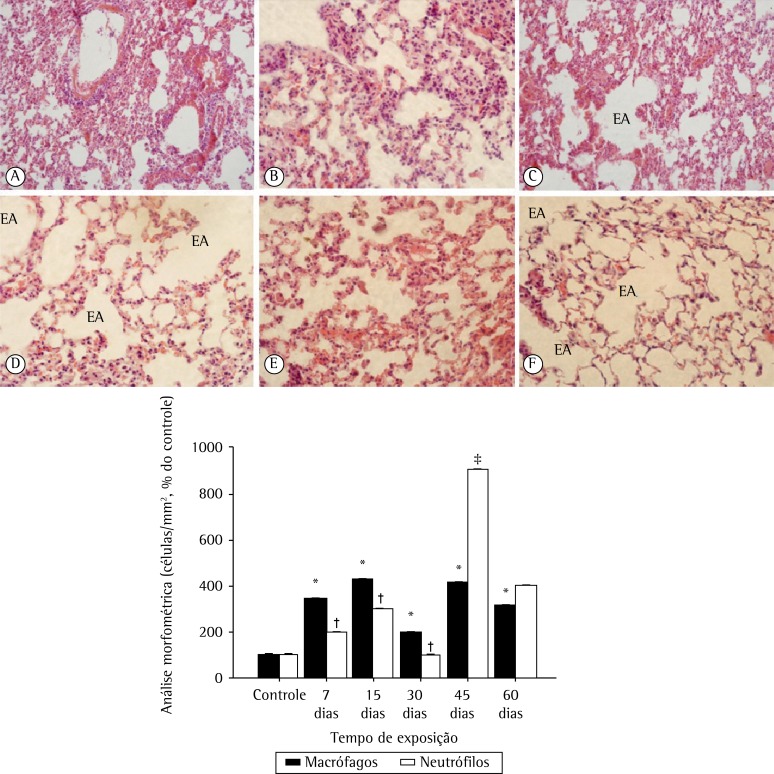
Em A, fotomicrografias de amostras de tecido pulmonar de camundongos
expostos a fumaça de cigarro mostrando aumento dos espaços aéreos (EA)
resultante da consolidação alveolar durante o desenvolvimento de enfisema
pulmonar (aumento, 40×): a, grupo controle; b, grupo exposto por 7 dias; c,
grupo exposto por 15 dias; d, grupo exposto por 30 dias; e, grupo exposto
por 45 dias; e f, grupo exposto por 60 dias. Em B, média ± EPM do número de
macrófagos e de neutrófilos (células/mm2). *p < 0,001 vs. controle para
macrófagos. †p < 0,001 vs. controle para neutrófilos. ‡p < 0,001 vs.
basal para neutrófilos.